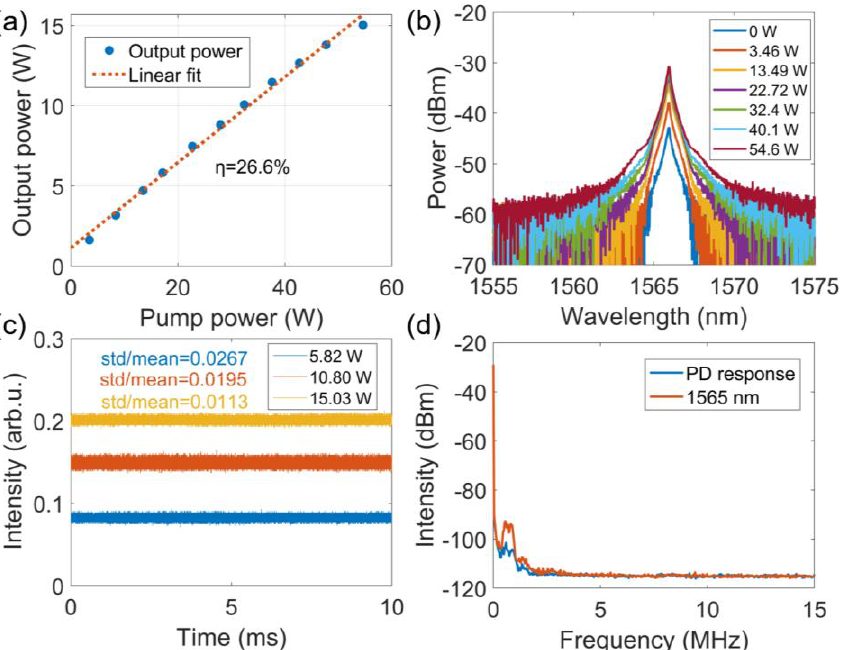
Figure 2. Characteristics of the amplified 1565 nm random lasing pump. ( a ) Output power versus the pump power; ( b ) optical spectra at different pump powers; ( c ) short-time temporal traces at different output powers; ( d ) radio frequency spectrum.